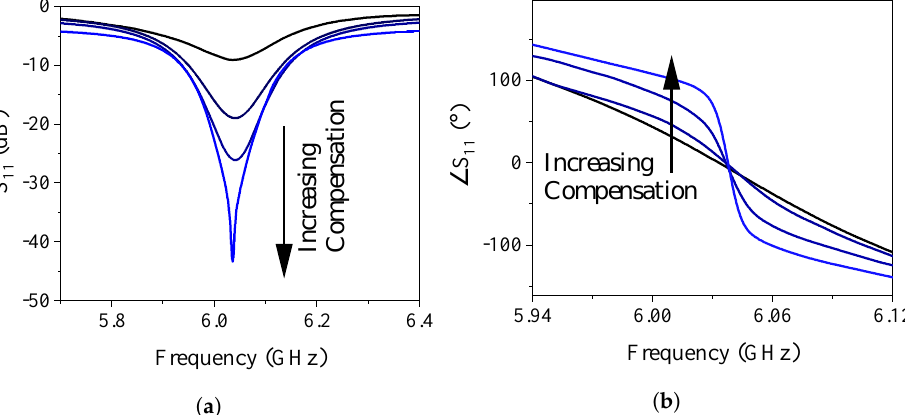
Figure 12. Reflection parameter modified due to negative resistance in ( a ) magnitude and ( b ) phase. Table 2. Performance comparison of passive and active sensor